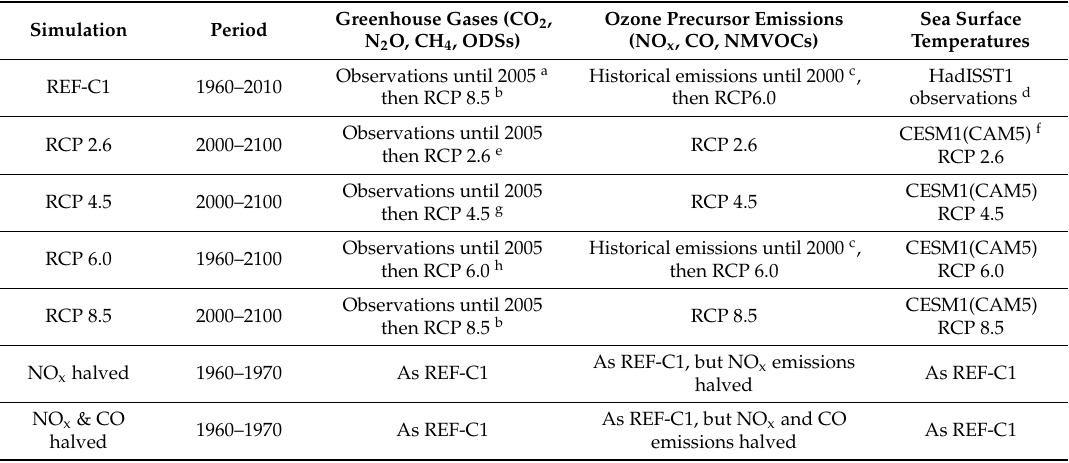
Table 2. Summary of boundary conditions used in SOCOL